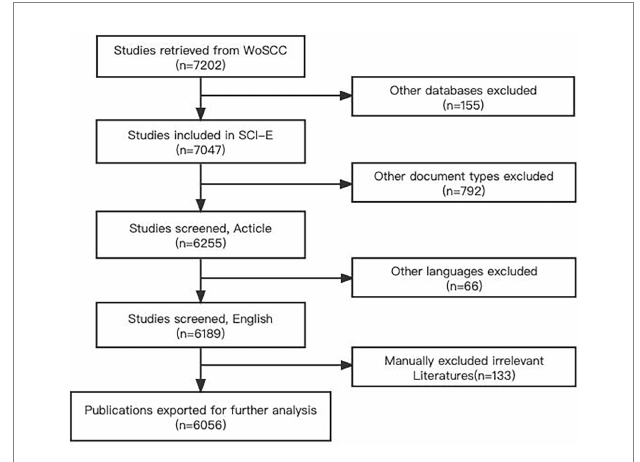
FIGURE 1 The flowchart of retrieving publications. WoSCC: the Web of